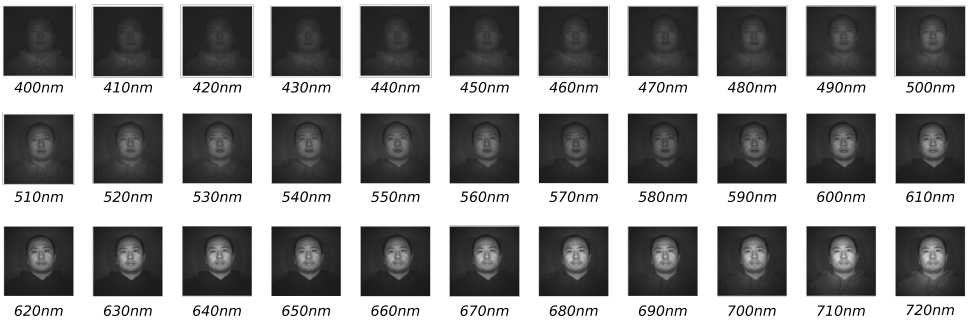
Figure 7. UWA-HSFD: Example of a subject’s face